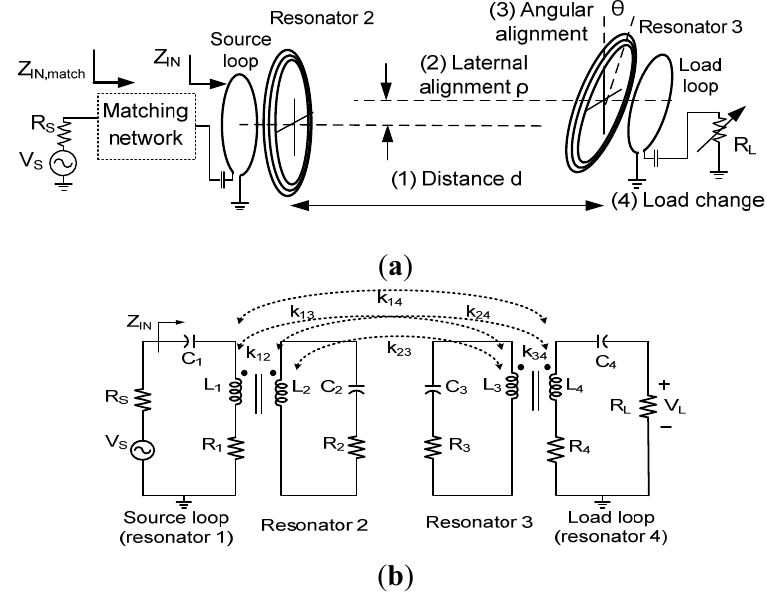
Figure 1. ( a ) Schematic of the wireless power transfer (WPT) system using resonant coupling; and ( b ) equivalent circuit model of resonant coupled